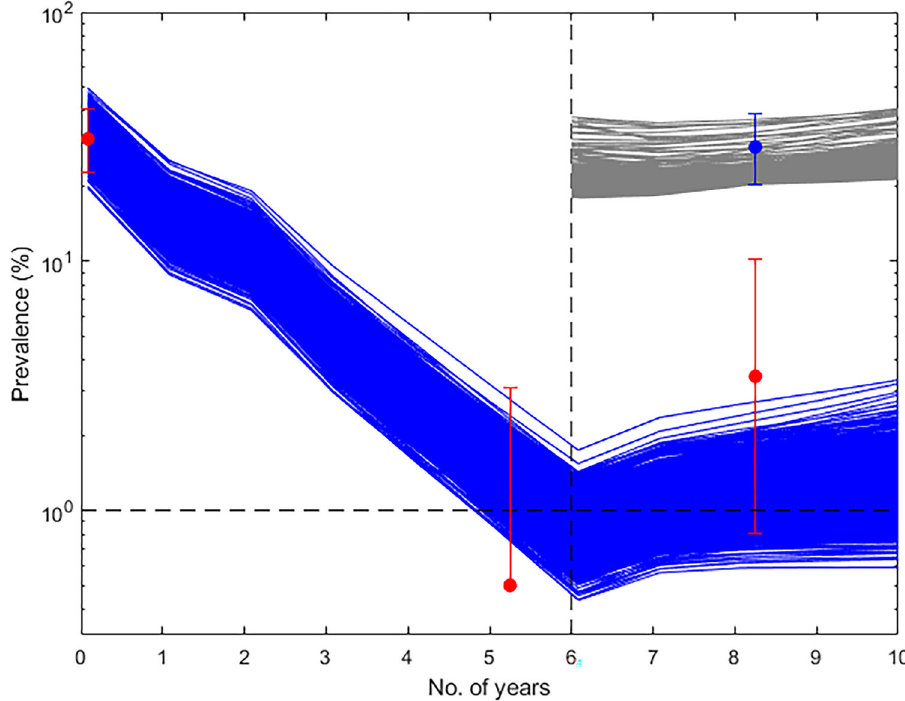
Fig. 6 Model-predicted impact of MDA on mf prevalence during seven rounds of MDA and after stopping MDA, and on CFA prevalence at the post- MDA survey in year 2008 for Leogane commune in Haiti. Blue lines indicate the predicted impact of the interventions on mf prevalence whereas gray lines indicate the predicted impact of the interventions on CFA prevalence. Red dots indicate fi eld-observed data points for mf while the blue dot is the corresponding data point observed for CFA. Horizontal and vertical black dotted lines indicate the WHO recommended 1% mf threshold and the time point of stopping MDA, respectively. Error bars indicate the 95% con fi dence intervals of the data